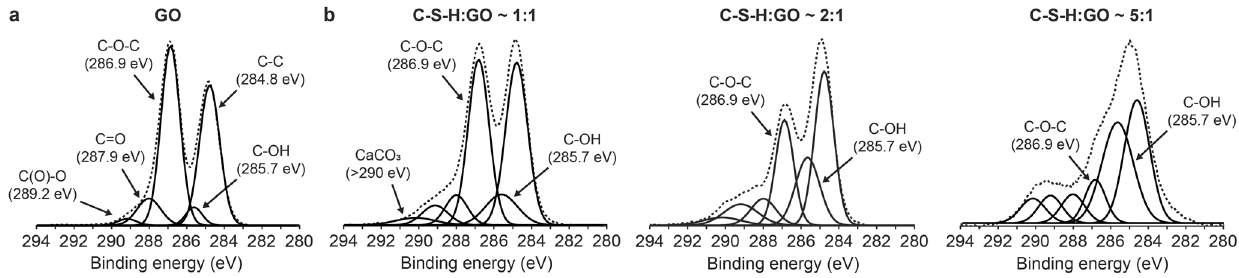
Fig. 4 XPS analysis unveiled the bonding nature between GO and C – S – H on GO – C – S – H mesosheets. a , b C 1 s XPS spectra of ( a ) GO and ( b ) GO – C – S – H mesosheets with different C – S – H:GO mass ratios indicating the chemical states of carbon in GO before and after the precipitation of C – S